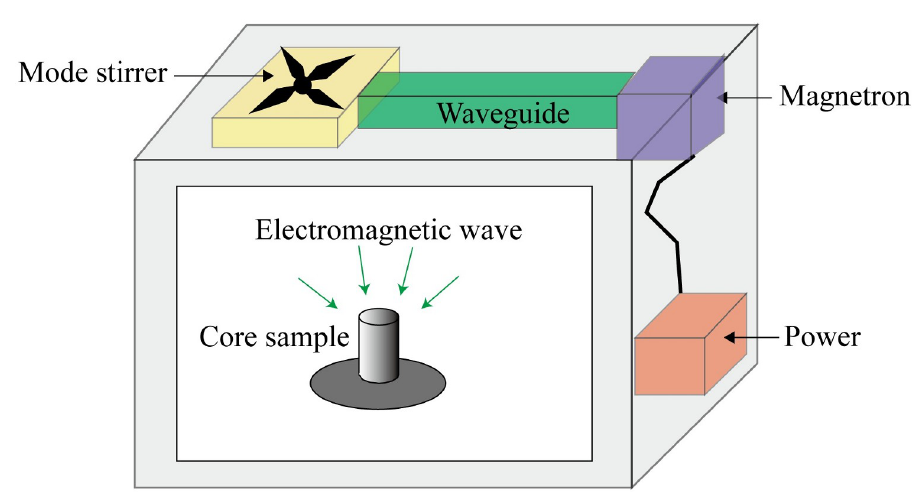
Fig 2. Schematic of the microwave oven used for investigating the pore structure of samples under electromagnetic radiation.